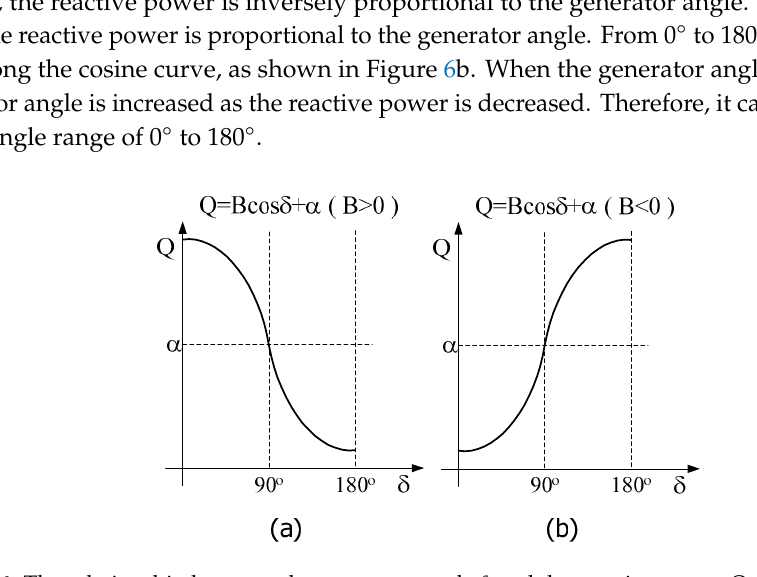
Figure 6. The relationship between the generator angle δ and the reactive power Q. ( a ) Q is inversely proportional to δ (B > 0). ( b ) Q is proportional to δ (B < 0).